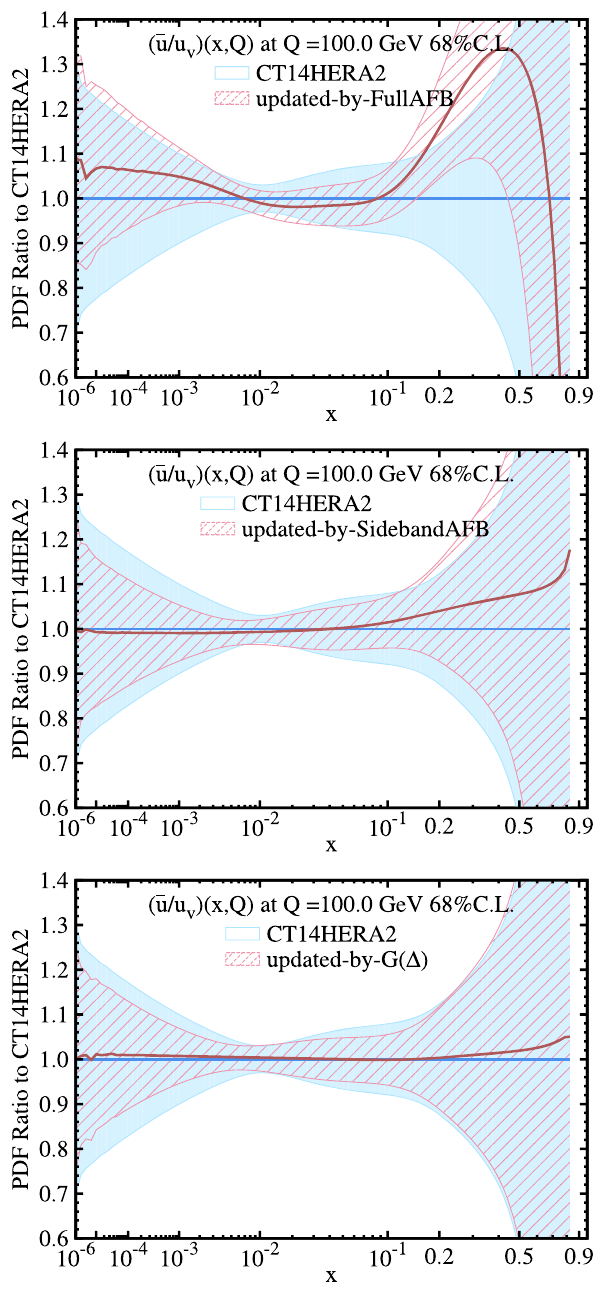
Fig. 5 The PDF ratio ¯ u / u valence to the CT14HERA2 central predic- tion before and after updating PDF with CF events in the pseudo-data = 0 . 2345). The left, middle and right plots correspond to (sin 2 θ (cid:4) eff using the full mass range A FB ( M ) , the sideband A FB ( M ) and the full mass range G (Δ) , respectively. The blue lines and error bands show the ratios before updating. The red lines and error bands show the ratios after updating. The x axis is the fraction of the effective parton energy with respect to the